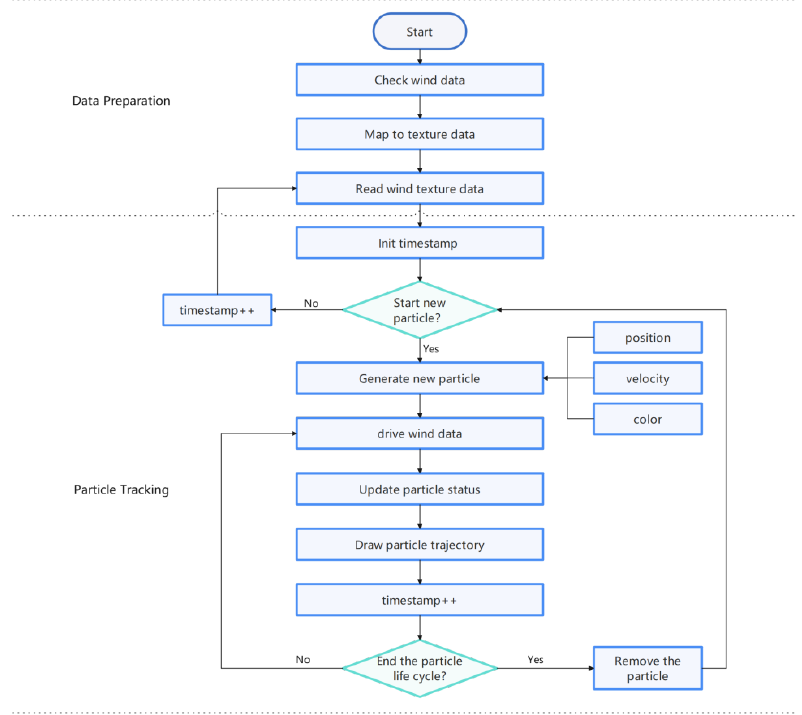
Figure 5. Particle trajectory rendering flow